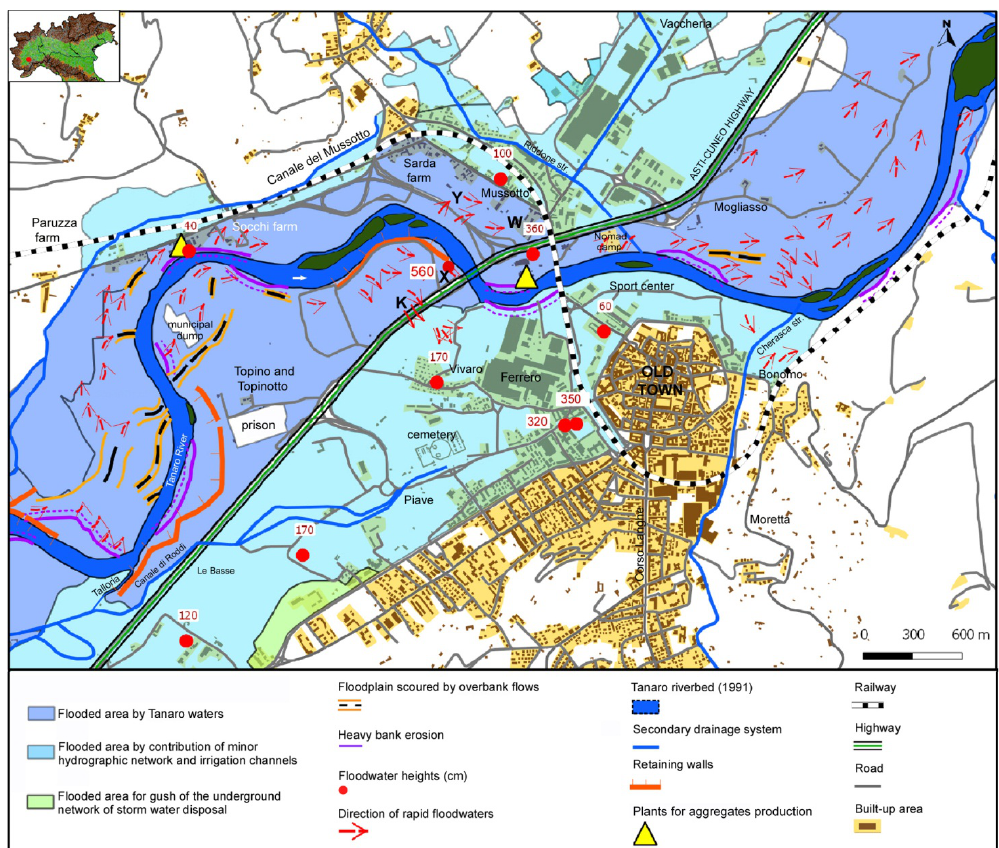
Fig. 2 - November 5-6, 1994 flooding in the Alba area. Fig. 2. 5–6 November 1994 flooding in the Alba